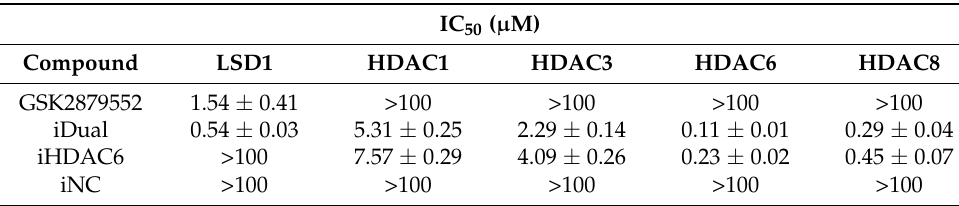
Table 1. LSD1, HDAC1, HDAC3, HDAC6, and HDAC8 enzyme assays with iDual, single mechanism positive controls GSK2879552 and iHDAC6, and the null compound iNC. IC 50 values are ± standard error from three independent measurements.